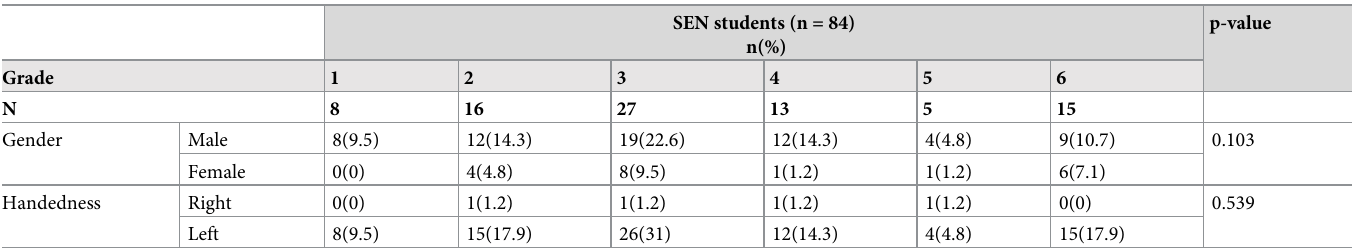
Table 5. Demographic characteristics of SEN